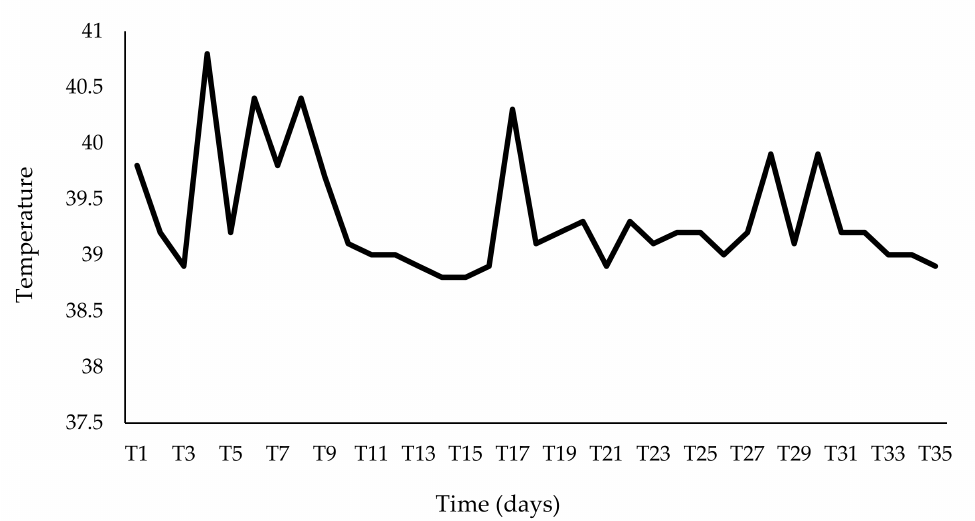
Figure 2. Trend of the temperature detected during the observation period. The fever compared